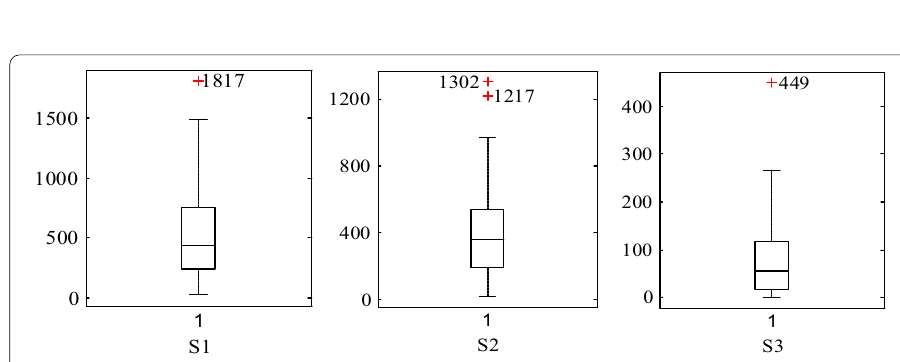
Fig. 5 Box-plot of VM request sequences. The first, second and third subgraphs demonstrate the outliers with red “ ” of the S1, S2 and S3 sequences, +